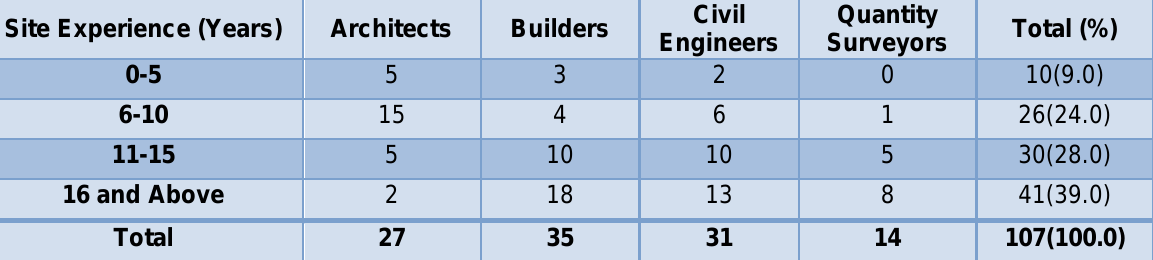
Table 3 Site experience of the respondents (source: Field work, 2008) Perception of Work Stress